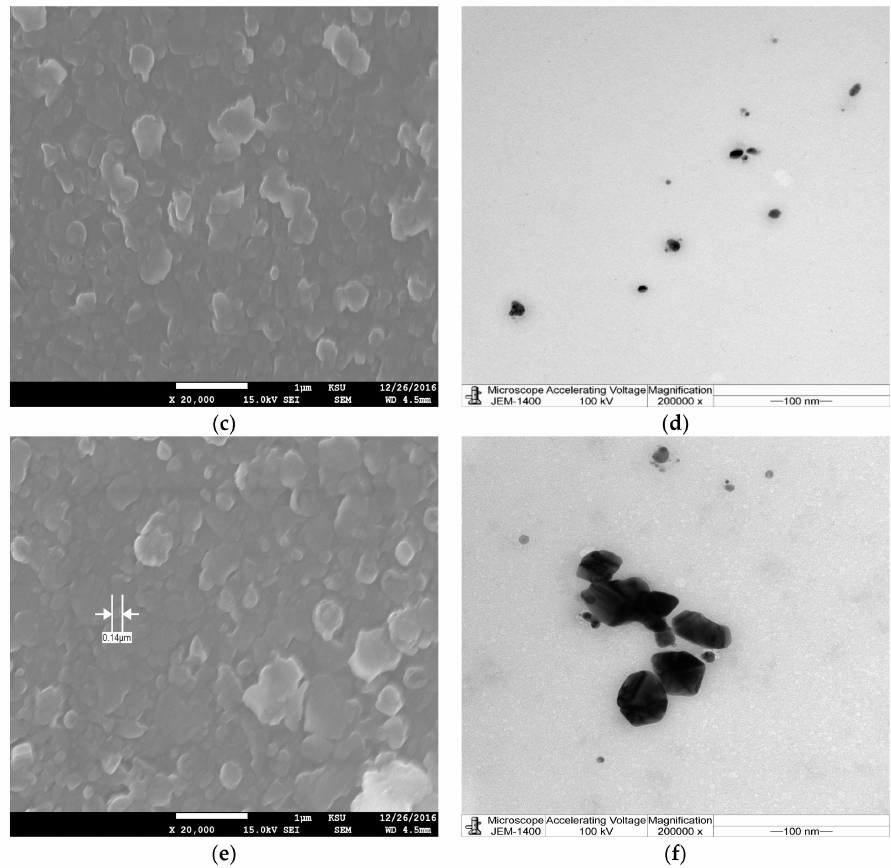
Figure 2. SEM images ( a – c ) and the corresponding TEM images ( d – f ) of silver nanoparticles obtained using aqueous extracts of Phoenix dactylifer , Acacia nilotica , and Ferula asafetida . Magnification is 20,000 × and scale bar represents 100 nm for TEM images and 1 µ m for SEM